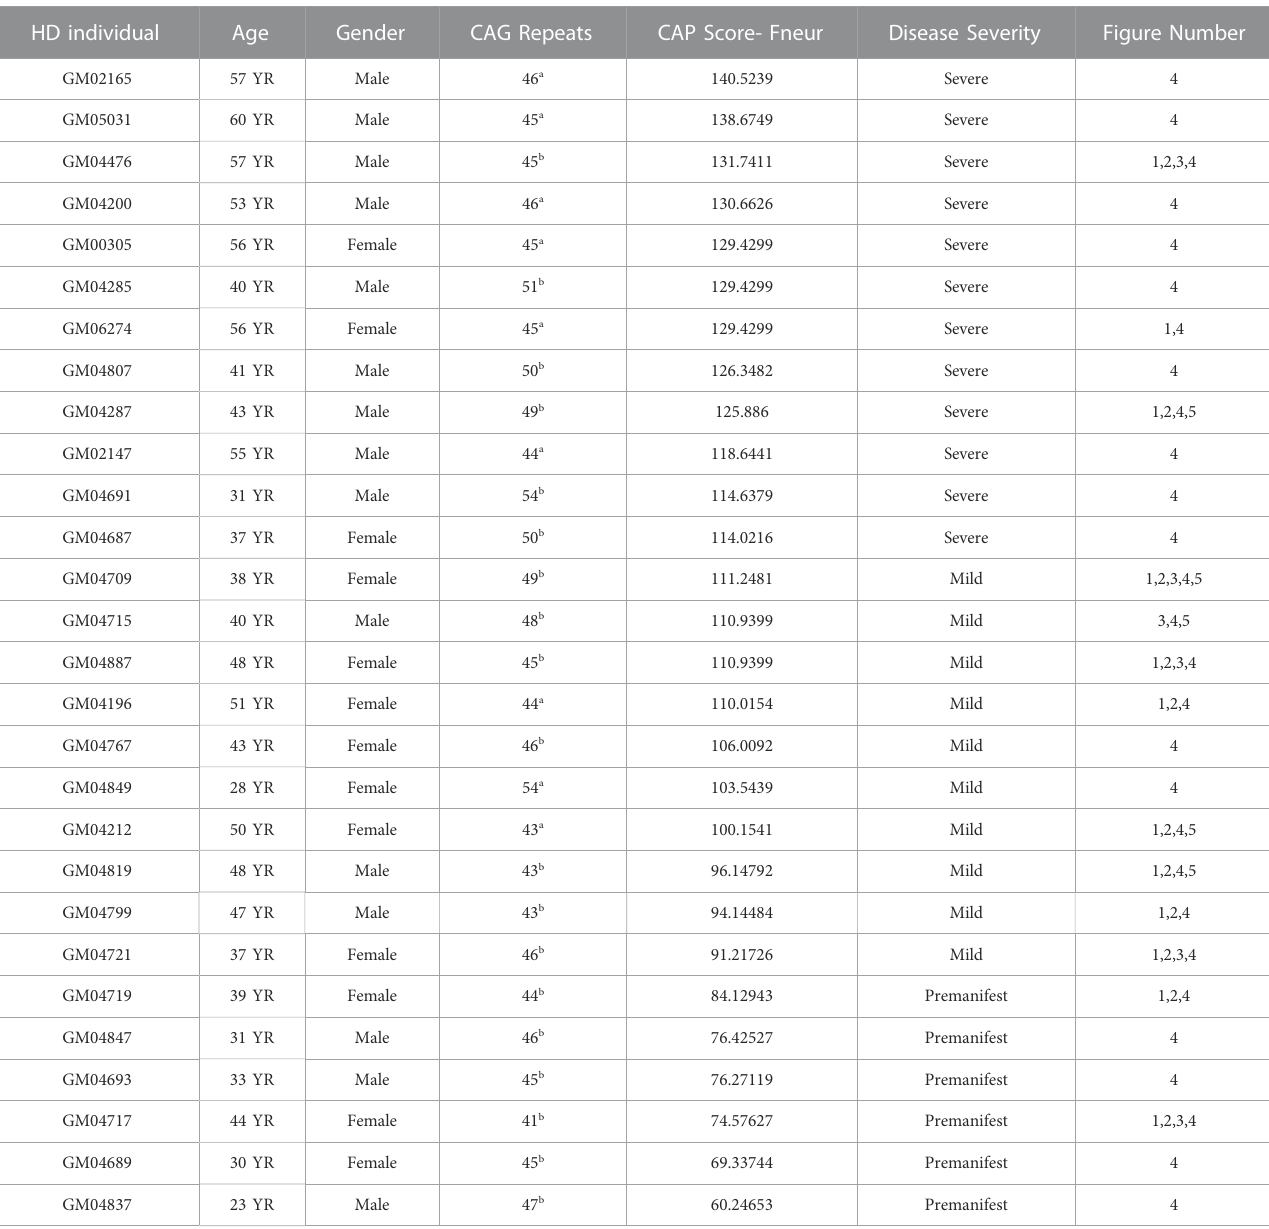
TABLE 1 List of skin fi broblasts samples of HD individuals. HD